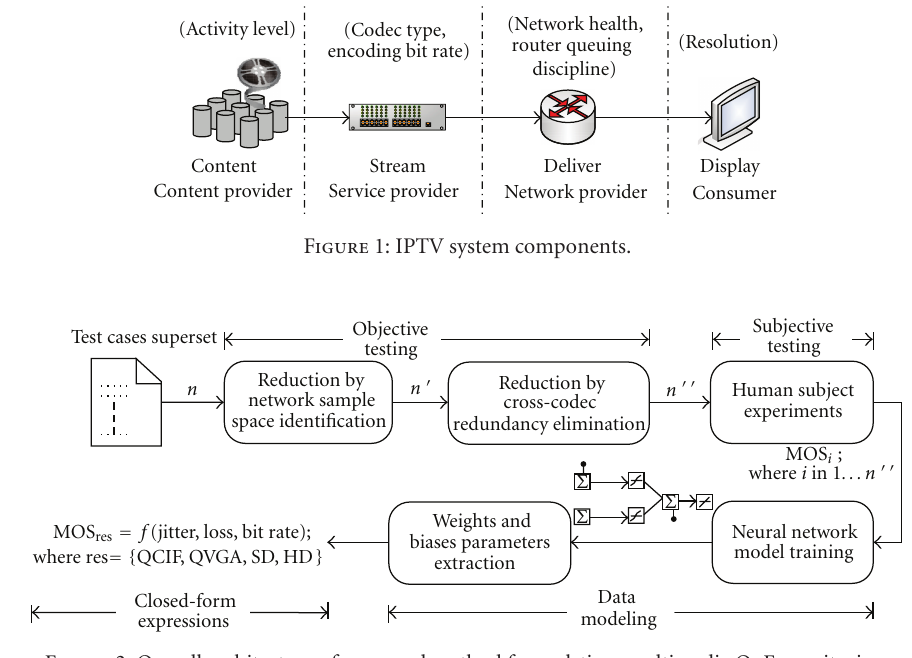
Figure 2: Overall architecture of proposed method for real-time multimedia QoE